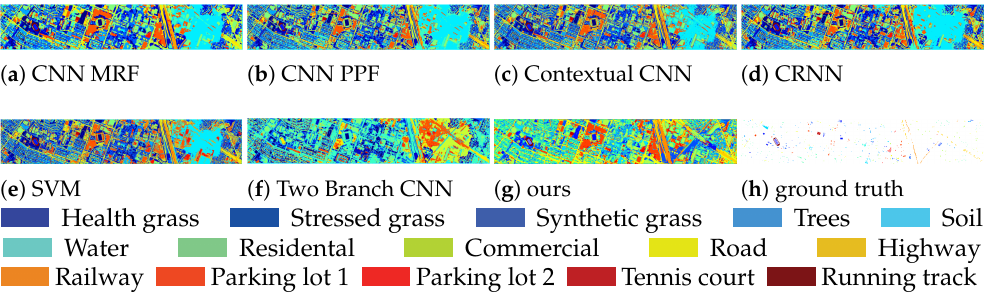
Figure 4. Visualization result of the Houston dataset in certain models.